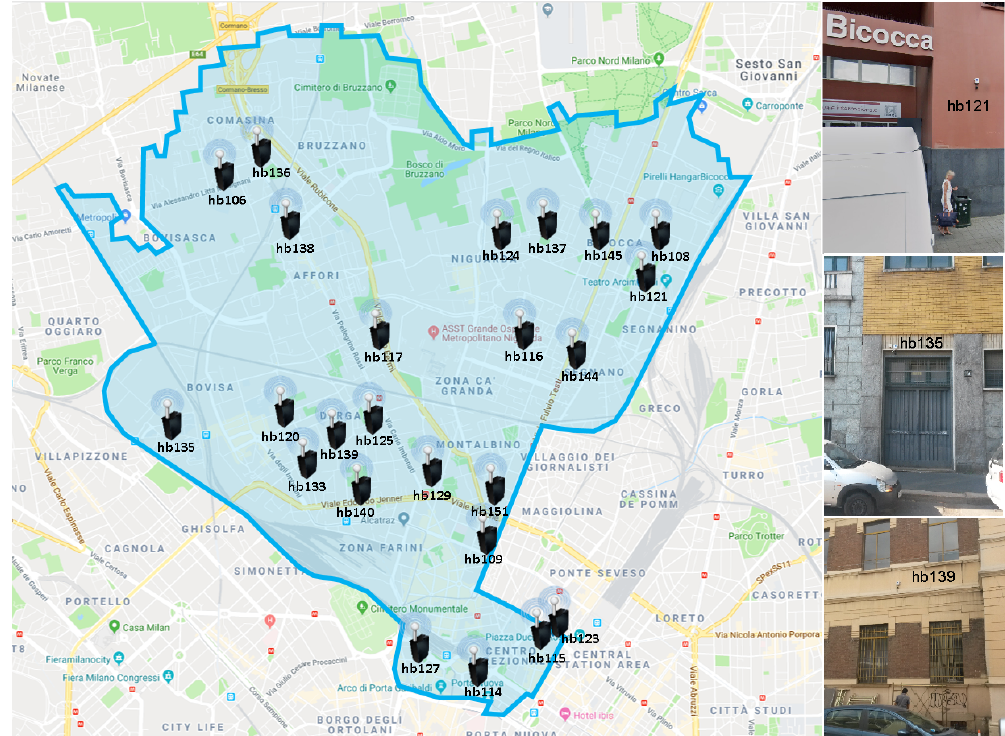
Figure 3. Map of the location of the 24-nodes of the WASN deployed within the DYNAMAP’s urban pilot area across the District 9 of Milan ( left ), showing the exact installation of three of them in the building facades ( right ) for illustrative